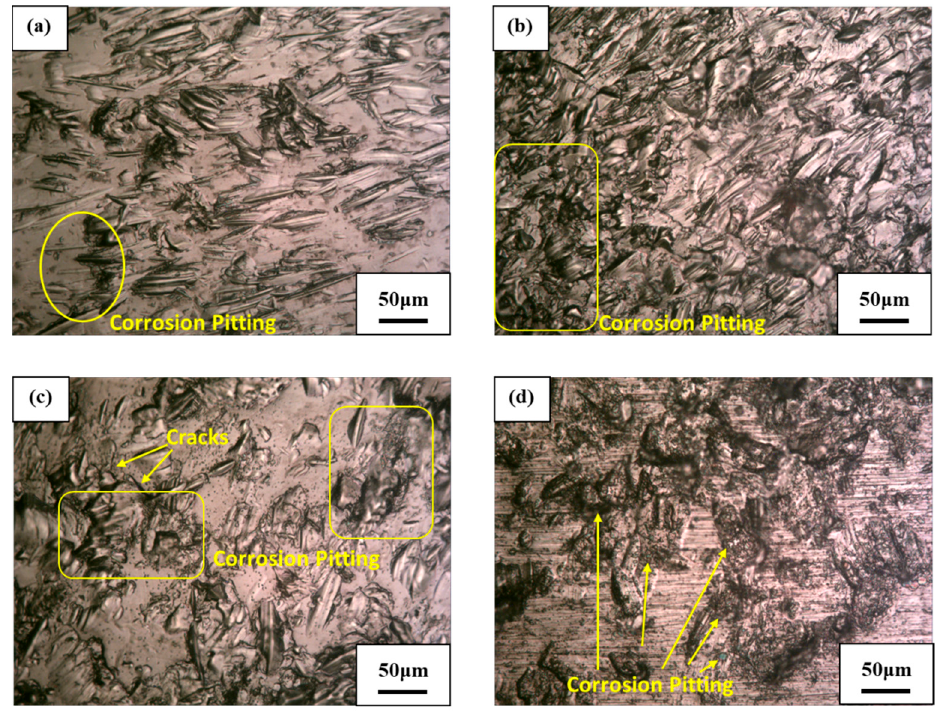
Figure 14. Optical microscopy morphologies of the SLMed Ti-6Al-4V alloy due to slurry erosion in seawater at impact angles of ( a ) 30°, ( b ) 45°, ( c ) 60°, and ( d ) 90°.